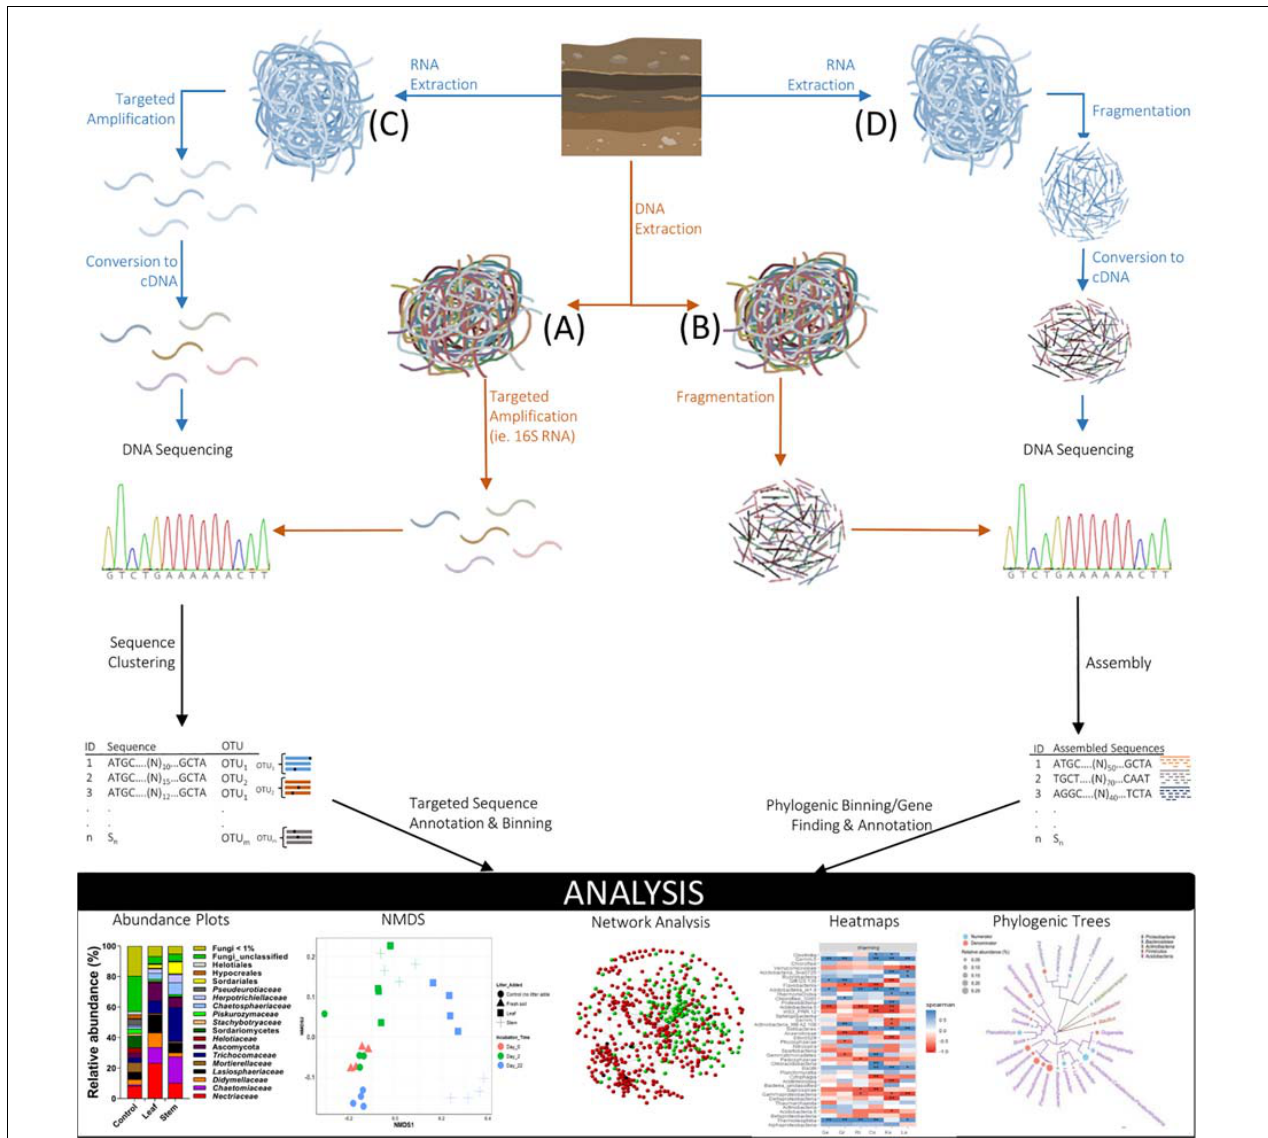
FIGURE 2 | Soil metagenomics and metatranscriptomic studies provide insight into population diversity and functional dynamics of soil microbial communities. Targeted gene sequencing (A) or shotgun sequencing of gene fragments (B) are common soil metagenomics approaches used to examine microbial population composition and can focus on particular gene sequences encoding for enzymes and other proteins involved with functional ecosystem processes. Metatranscriptomics involves the extraction of RNA, targeted amplification (C) or fragmentation (D) , and conversion to cDNA prior to DNA sequencing, to provide contemporaneous information of community functional processes (such as SOM stabilization) actively occurring in